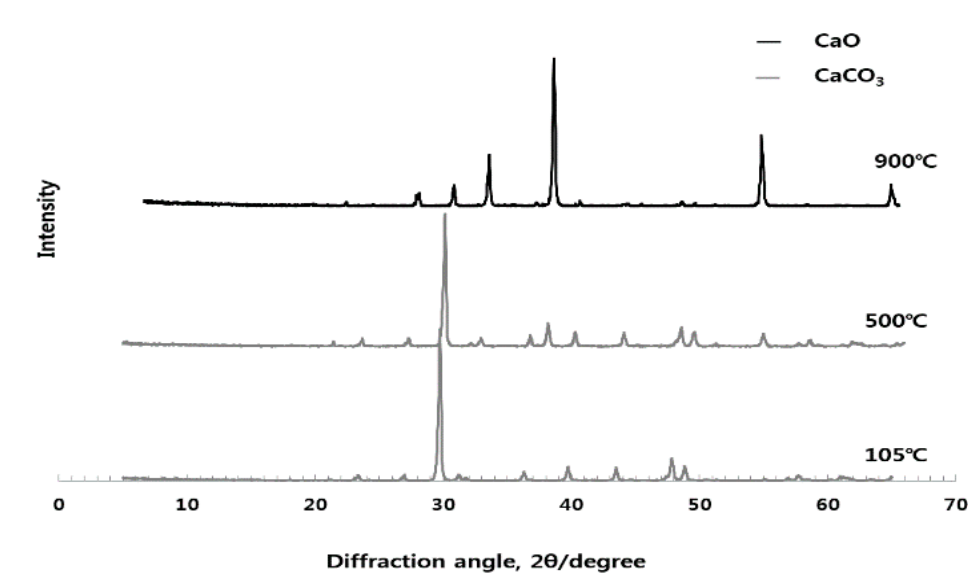
Figure 4. Quantitative analysis of the crystal structure of LP at different burning temperatures.